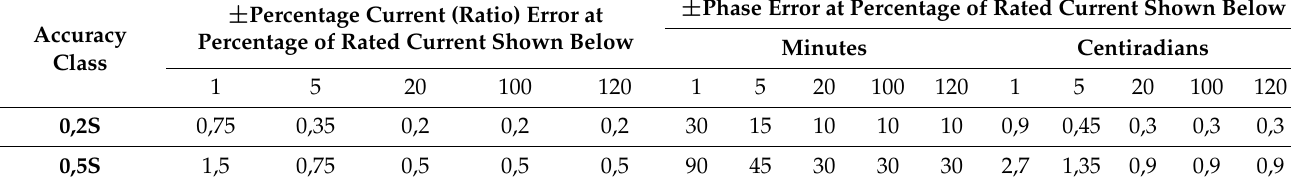
Table 2. IEC special application metering class specifications.